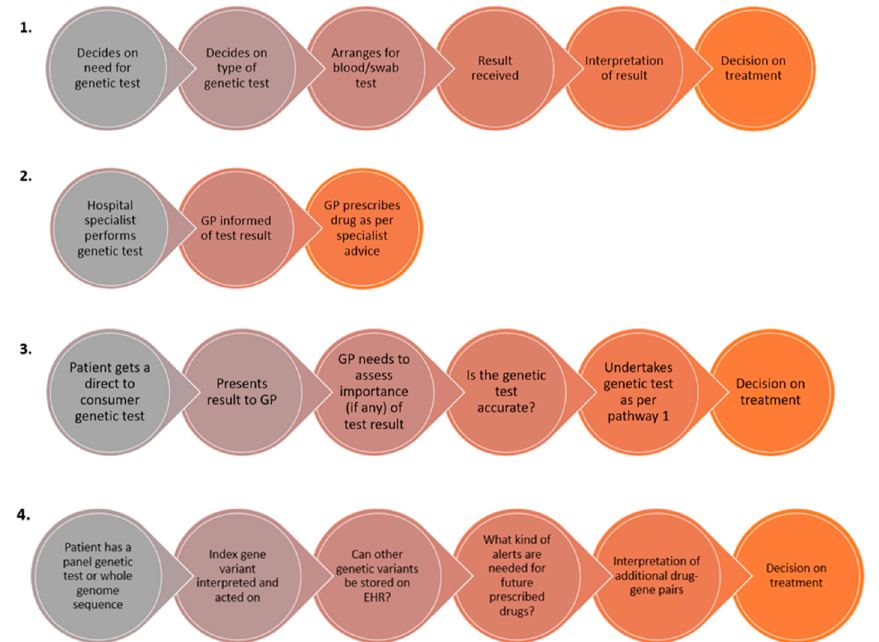
Figure 2. Four hypothetical pathways through which GPs may encounter pharmacogenetic tests within their primary care practice. Pathway 1 is where the GP initiates the test themselves; pathway 2 is where the genetic test is carried out in secondary care and the GP is informed of the test result; and pathway 3 is where the patient presents to the GP having undertaken a test privately or via a direct to consumer genetic testing laboratory. Pathways 1–3 represent situations where a single patient has undergone a panel test or exome/whole genome sequencing, where there is the added storing the rest of the genetic data and having the ability to retrieve it, and use it appropriately in